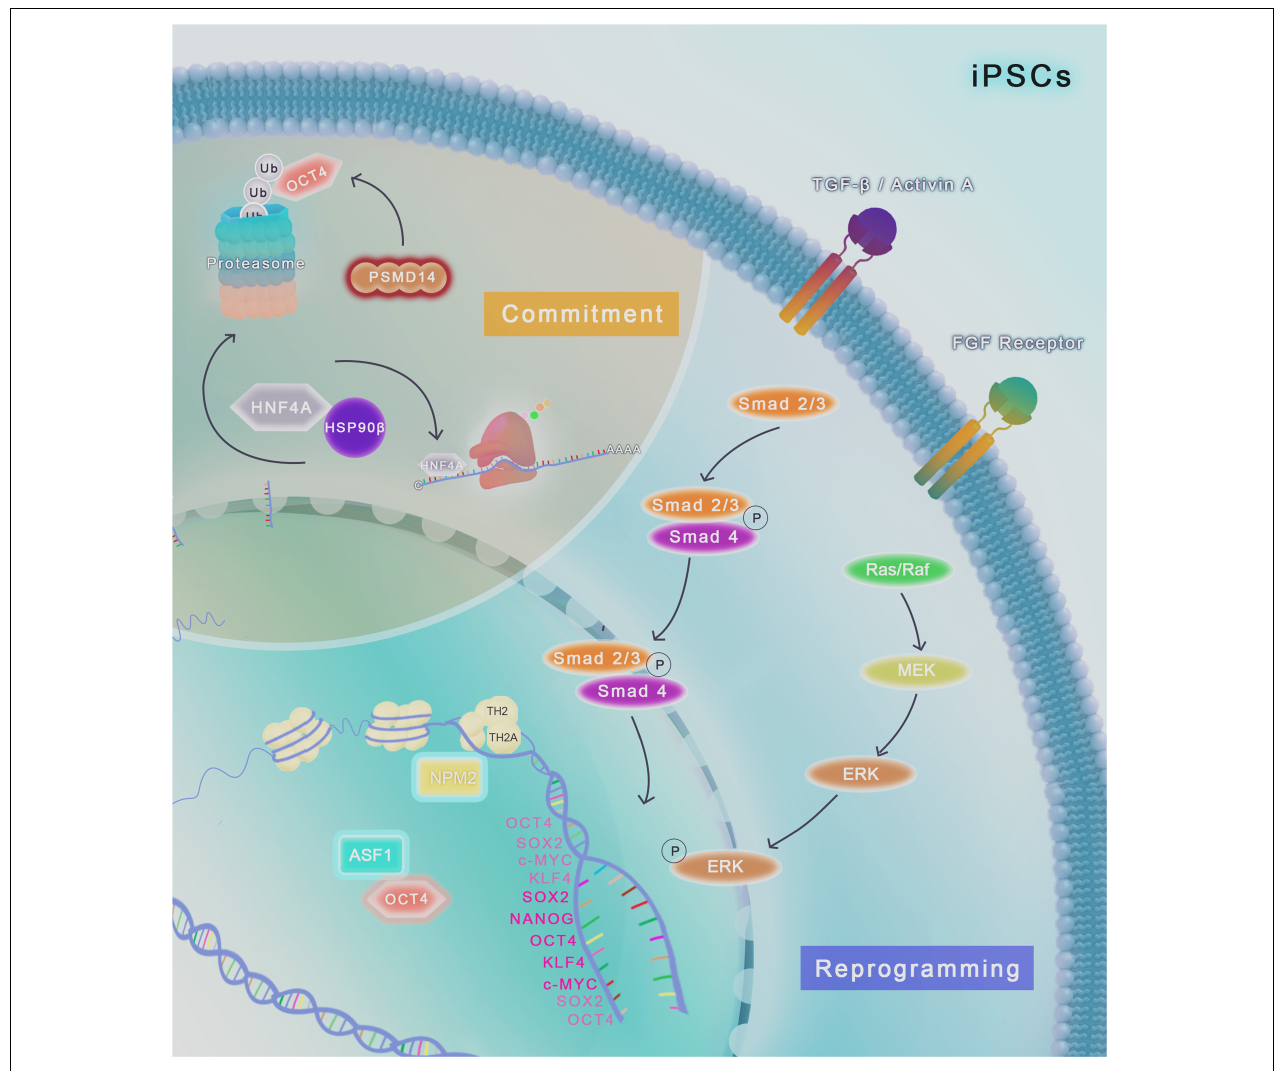
FIGURE 2 | Chaperome regulation and proteostasis network in human iPSCs. TGF- β /Activin A and FGF2/Ras/MEK/ERK pathways are required for the maintenance of iPSCs in culture conditions. The histone chaperone NPM2 binds to the histone variants TH2A and TH2 and improve the reprogramming of human fibroblast into iPSCs modulated by OCT4, SOX2, KLF4 and c-MYC, generating more naïve human iPSCs compared to factors induction alone. ASF1a histone chaperone upregulation, together with OCT4, also has an important role in reprogramming of human fibroblast. Cell fate commitment (highlighted in light brown) involves the induction of different specific pathways that can lead to differentiation into various cell types. The molecular chaperone HSP90 β physically binds to HNF4A and control the protein turnover of these client, modulating differentiation of iPSCs to endoderm-derived hepatic progenitor cells. Downregulation (represented as a red glow around the molecule) of the proteasome-related protein PSMD14, a 26S proteasome subunit, impairs the deubiquitylation of OCT4, leading to its degradation in the proteasome and impairment of